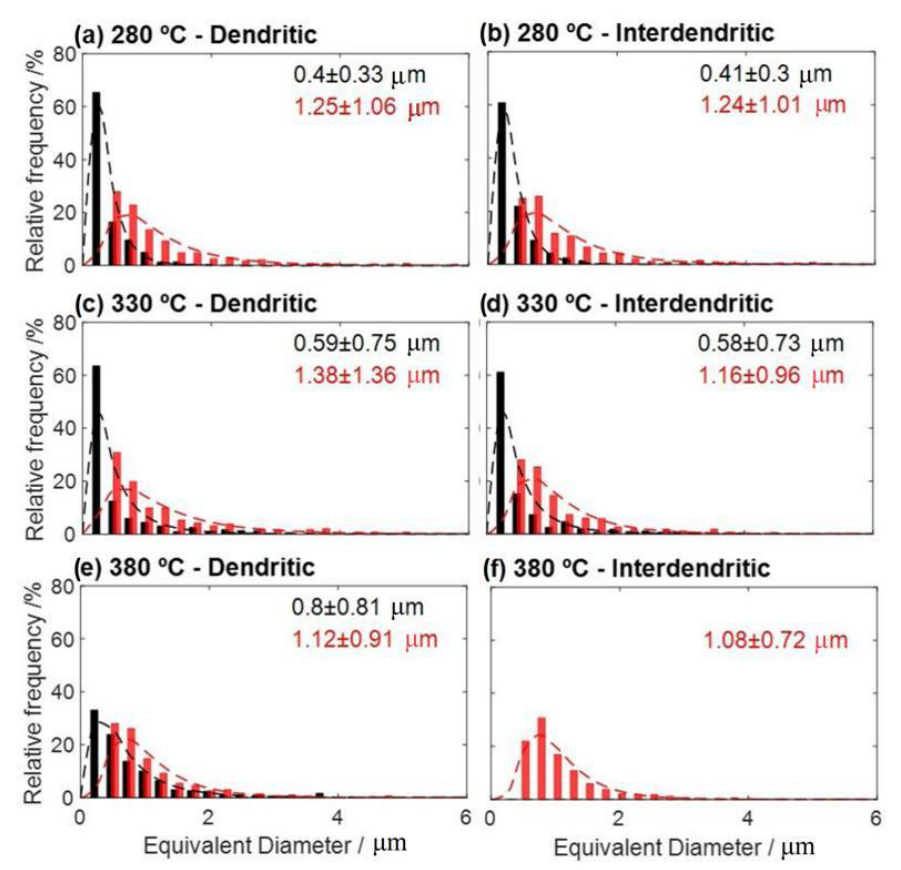
Figure 14. Retained austenite (black) and ferrite block (red) size relative frequency distribution expressed as the equivalent circle diameter of each grain area for the conditions ( a ) 280—Dendritic; ( b ) 280—Interdendritic; ( c ) 330—Dendritic; ( d ) 330—Interdendritic; ( e ) 380—Dendritic; ( f ) 380—Interdendritic. Black and red dashed lines represent lognormal fittings to the experimental distributions. On the top part of each plot box, one can find the mean austenite and ferrite block grain equivalent diameter, which is followed by the standard deviation.